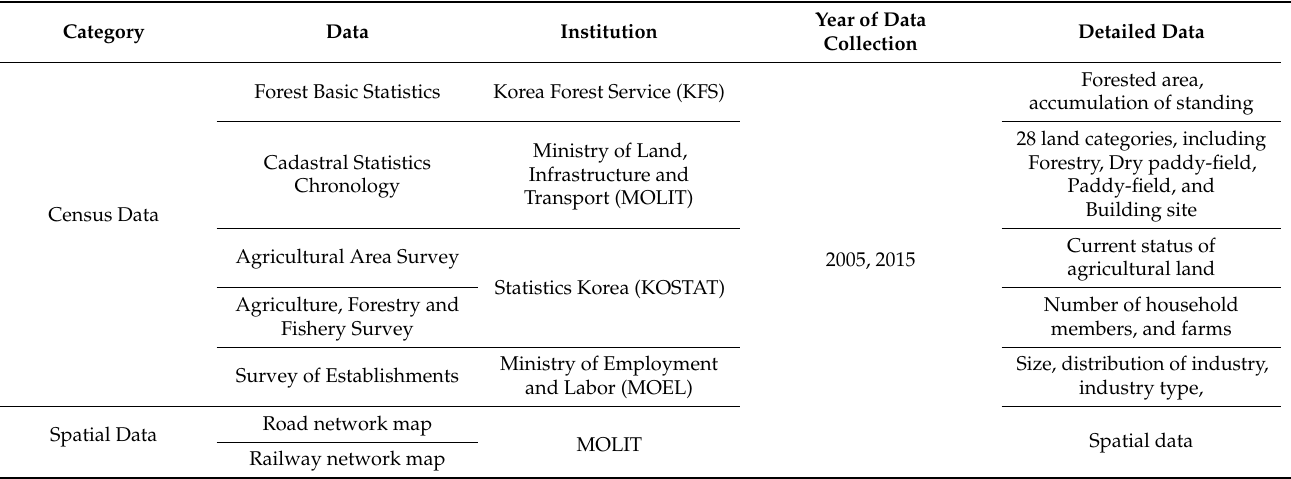
Table 2. Sources of data for factors affecting forest